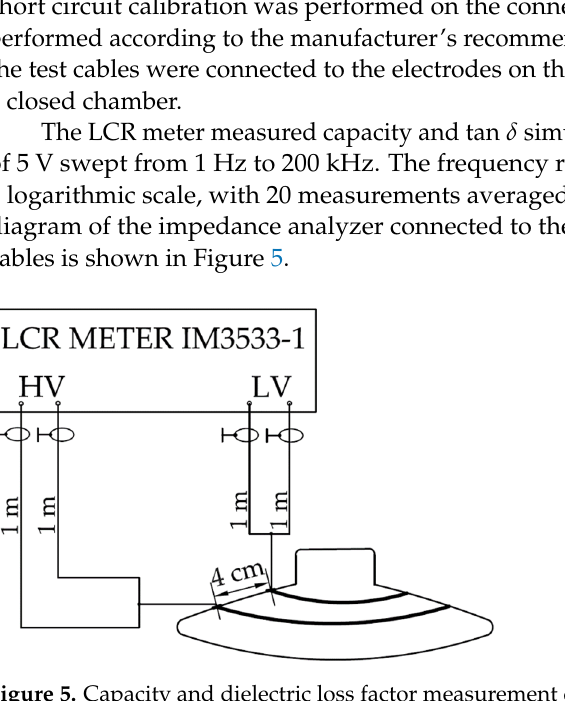
Figure 5. Capacity and dielectric loss factor measurement diagram.